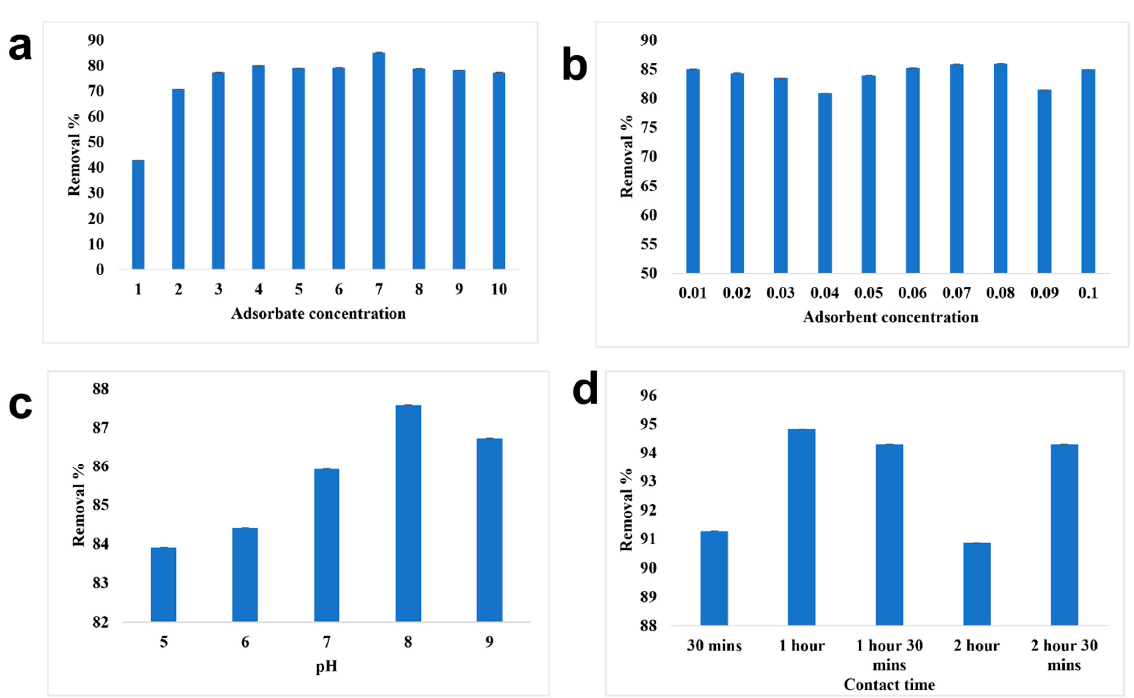
Figure 9. Batch adsorption study of alginate–SPION microspheres. ( a ) Optimization of adsorbate concentration, ( b ) Optimization of adsorbent concentration, ( c ) Optimization of pH, ( d ) Optimiza- tion of contact time.